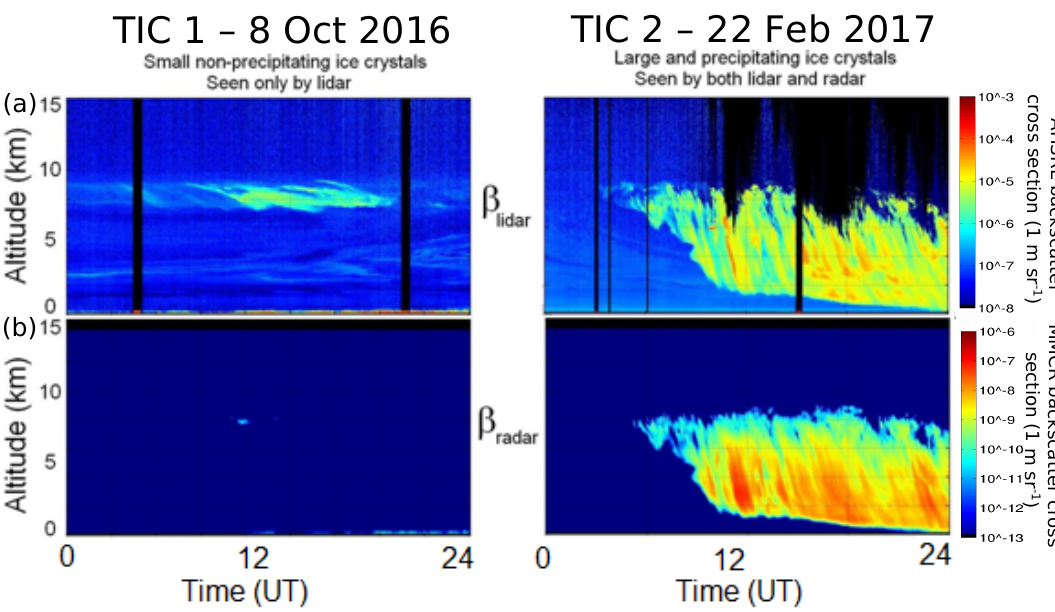
Figure 1. Classification of thin ice clouds using ground-based lidar (up) and radar backscatter profiles (bottom). Table 1. List of the Eureka (PEARL) instruments employed in our analysis. Ground-based instrument Duty cycle Research group or institution AHSRL (Arctic High Spectral Resolution Lidar) Continuous SEARCH/NOAA – University of Wisconsin–Madison MMCR (Millimeter Cloud Radar) Continuous SEARCH/NOAA – ARM Radiosonde Twice a day Environment Canada P-AERI (Polar-AERI) Continuous SEARCH/NOAA – University of Idaho (except during